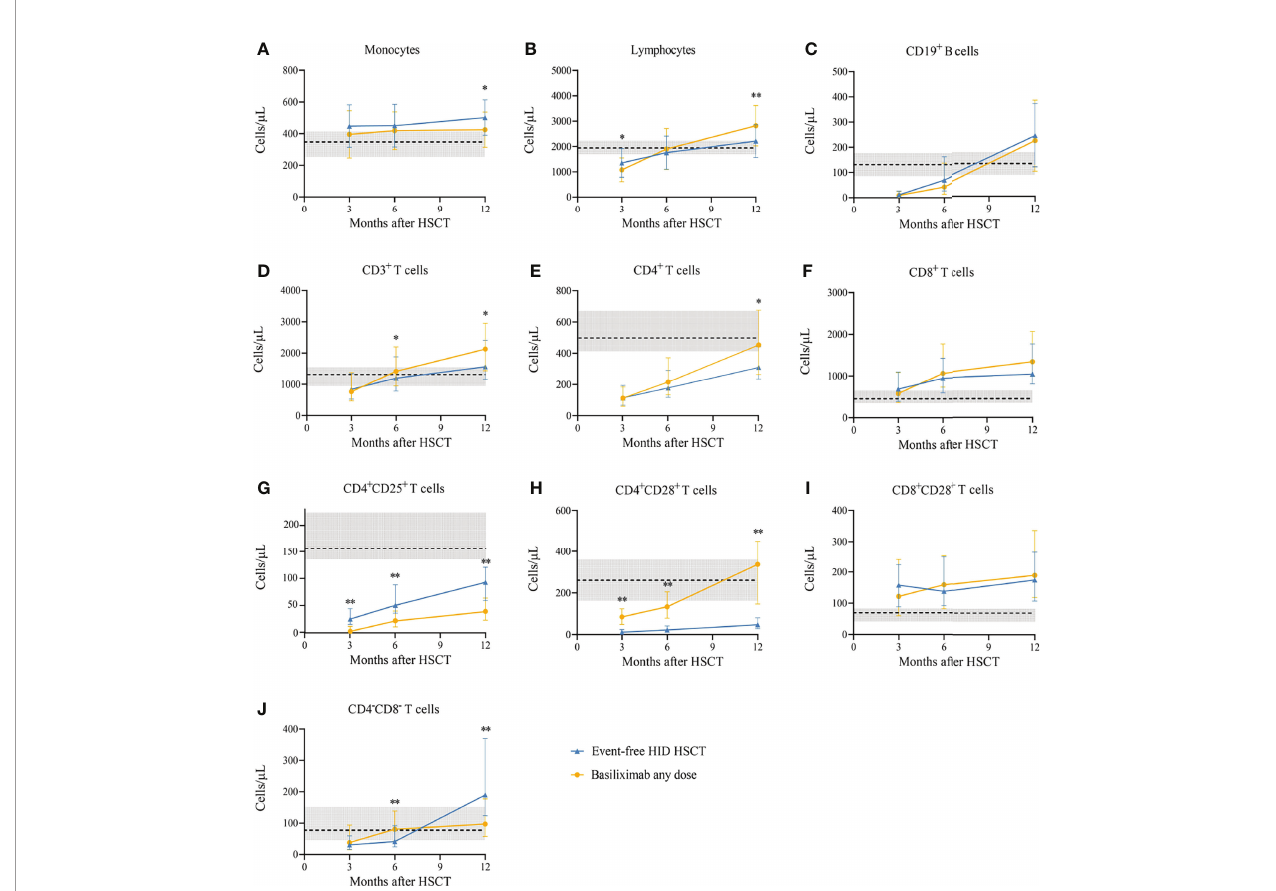
FIGURE 6 | (A-J) Immune reconstitution between SR-aGVHD patients who showed an ORR after basiliximab treatment and event-free HID HSCT recipients. Data are shown as median absolute counts with error bars indicating the 25th – 75th percentiles. The horizontal dotted lines represent the median value of healthy cohorts, and the gray areas represent the 25th – 75th percentiles for the healthy cohorts. * P < 0.05, ** P < 0.01, basiliximab any dose vs. event-free HID HSCT. HID HSCT, haploidentical donor hematopoietic stem cell transplantation; ORR, overall response rate; SR-aGVHD, steroid-refractory acute graft-versus-host